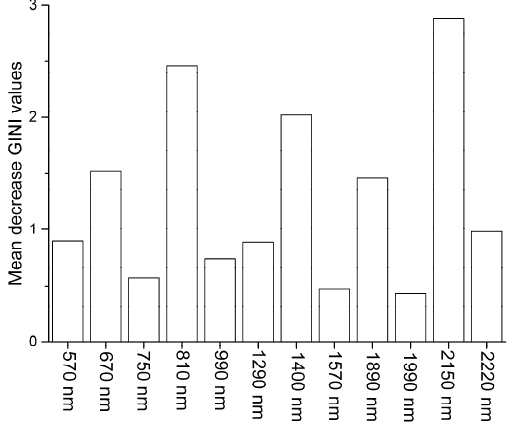
Figure 4. Mean decrease GINI values for RELIEF-selected spectral features.